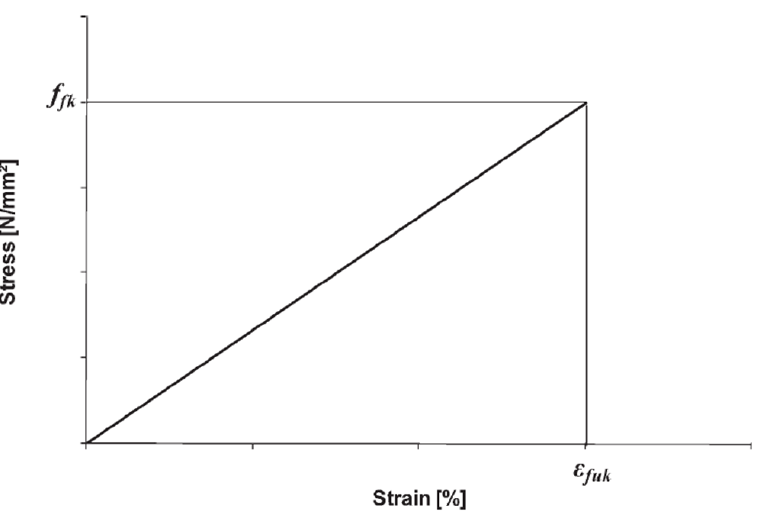
Figure 10. Idealized stress–strain diagram for BFRP bars.